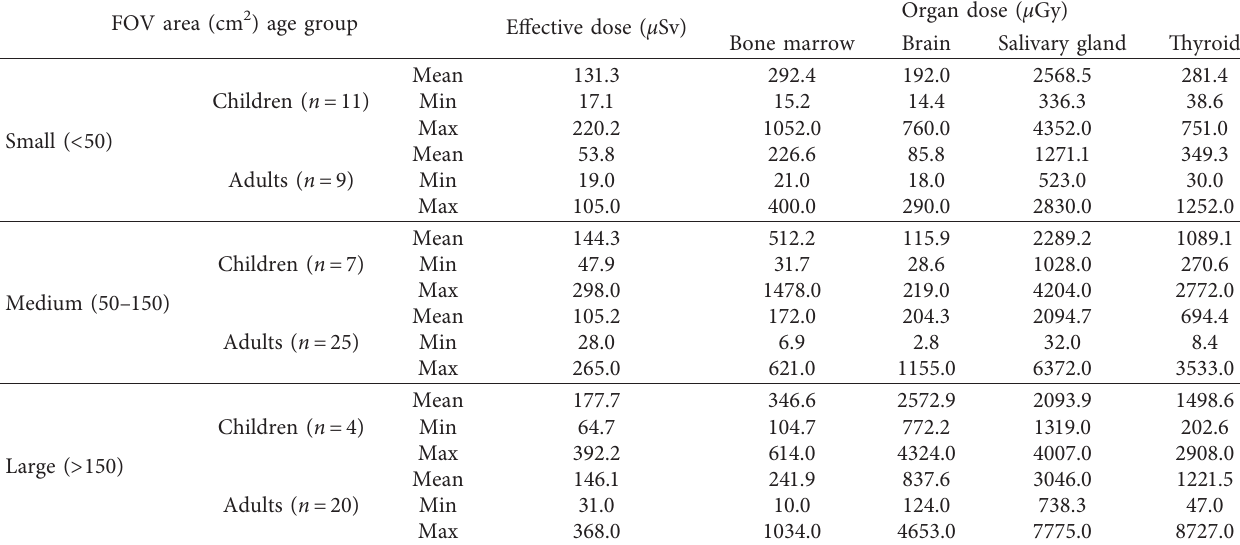
Table 8: Minimum, mean, and maximum values of effective and organ (bone marrow, brain, salivary gland, and thyroid) doses from cone- beam computed tomography procedures by age group (children and adults) and field-of-view area (FOV width × height, cm 2 ) reported in the selected